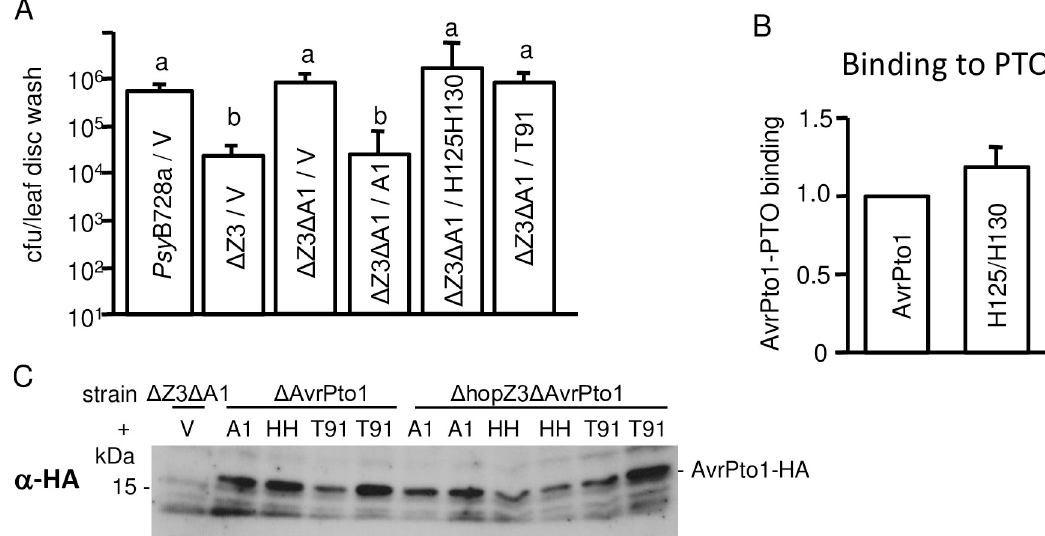
Fig 5. Effect of mutations of AvrPto1 acetylation sites on Psy B728a growth in tomato. (A) AvrPto1 _T91A and H125A/ Psy Psy H130A mutants did not reduce Psy B728a growth in PTO-containing tomato in the absence of HopZ3. Plants were spray- inoculated with indicated strains at an OD 600 = 0.01. Epiphytic bacterial populations were quantified in leaf disc washes from eight different plants per strain four days after inoculation. Different letters indicate significant differences in growth as assessed by ANOVA with Tukey’s test (P < 0.05). Similar results were found in at least two other experiments (AvrPto1 Psy _H125A/H130A did not reduce the growth of Psy B728a Δ HopZ3 in three out of five experiments). Bars indicate standard errors. V, vector control; A1, AvrPto1 Psy ; Z3, HopZ3; T91, AvrPto1 Psy _T91A; H125/H130 and HH, AvrPto1 Psy _H125A/H130A. (B) H125A/H130A mutation of